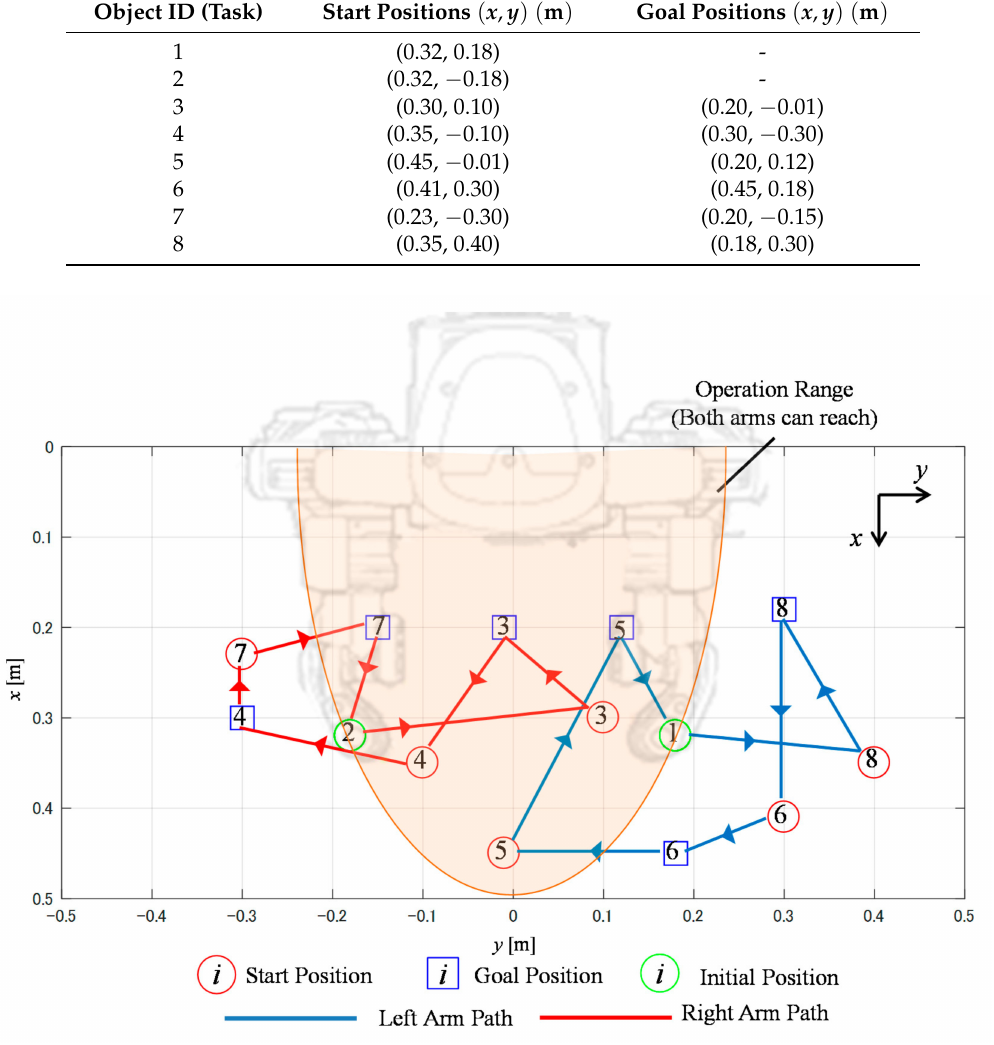
Figure 4. Solution obtained by the proposed